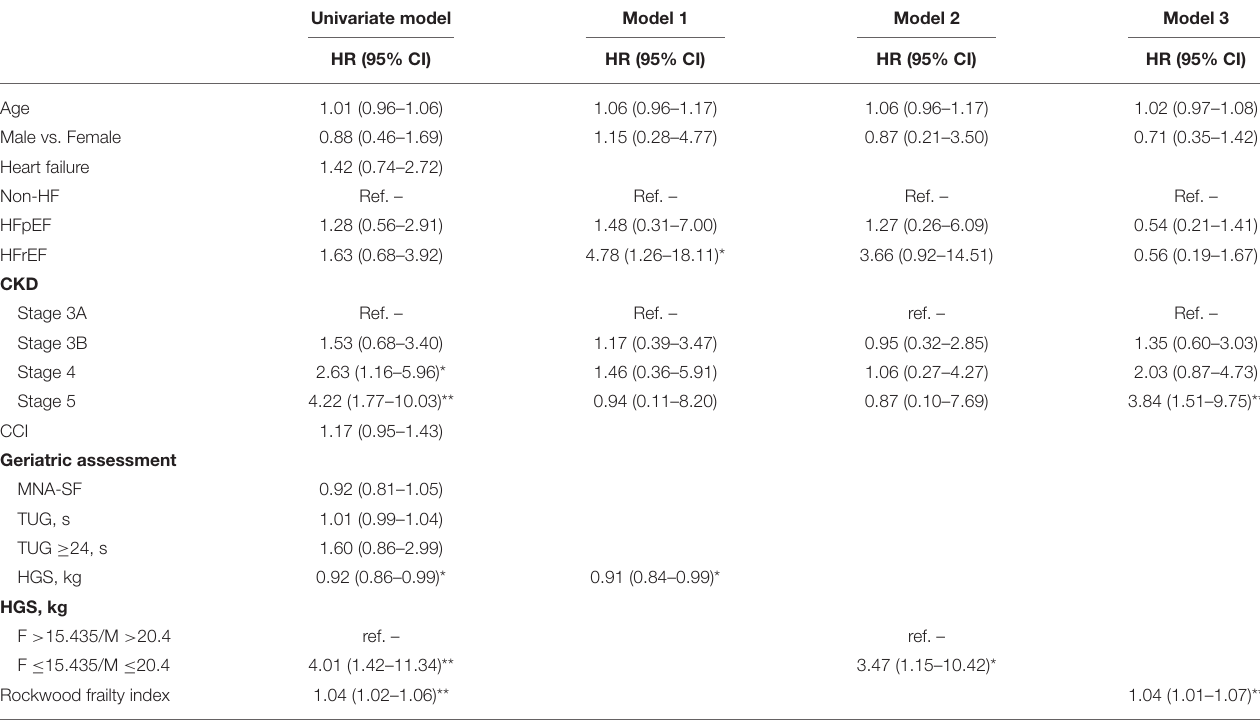
TABLE 5 | Predictors of all-cause mortality in older CKD